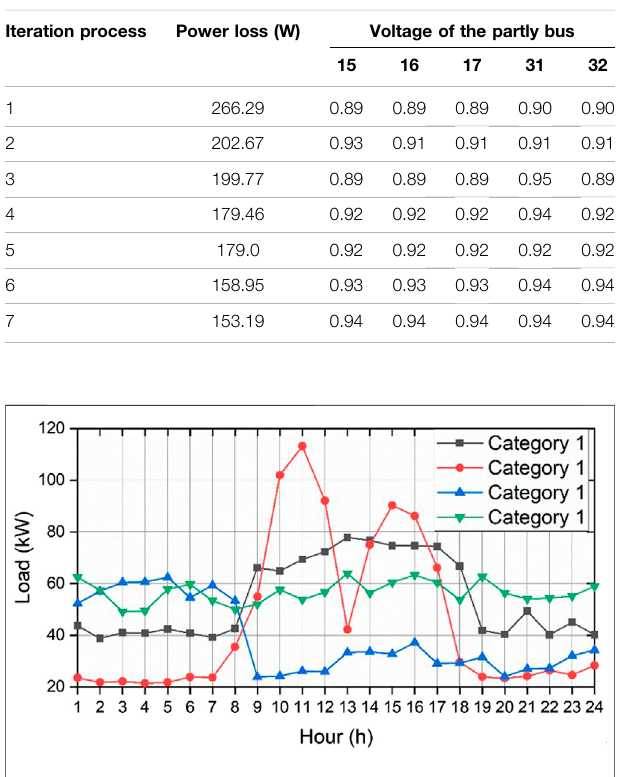
88% of the data are used to train the model and 12% are used to test the model. The input data consist of a cell array with four dimensions, and the output data are an array with one dimension, resulting in four units in the input layer and one unit in the output layer. The learning process using the MATLAB toolbox is shown in Figure 7 . Root-mean-squared error (RMSE) is the error between the predicted value and true value. From Figure 7 , the RMSE is almost 0 near the 5000th iteration and remains stable at around 0 with minor fl uctuations. The “ Loss ” in the bottom graph re fl ects the changes in the loss function during the iteration process; the